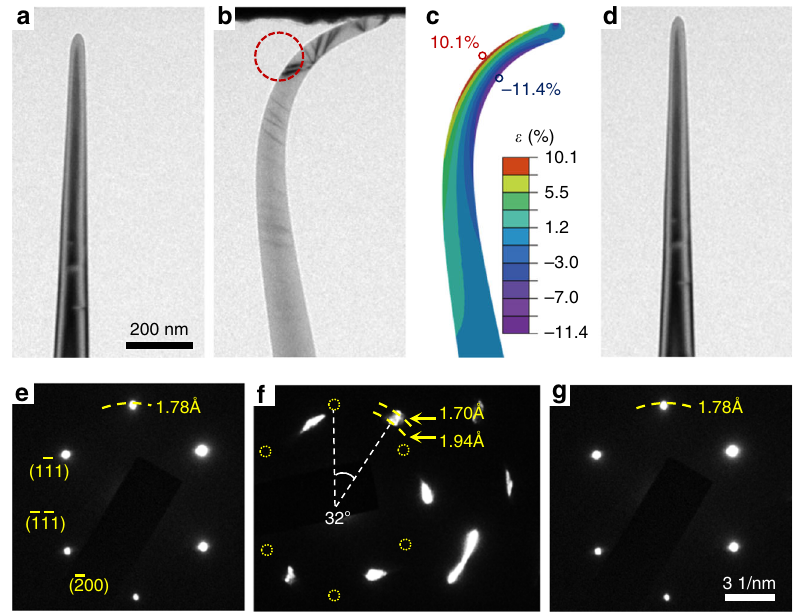
Fig. 2 An example of reversible bending tests and associated lattice expansion determined by electron diffraction. a A TEM image of a <100> diamond nanoneedle with a tip diameter of ~50 nm. b The same nanoneedle during compression. c Finite element methods (FEM) simulation reproducing the shape in b revealing the maximum tensile strain (10.1%) located at the red circle. d The same nanoneedle, after unloading. The nanoneedle returns to its original shape. e-g Selected area electron diffraction (SEAD) patterns taken during the bending test at strain states of a , b , d , respectively. f was taken from the highly curved region (the red circled) in b